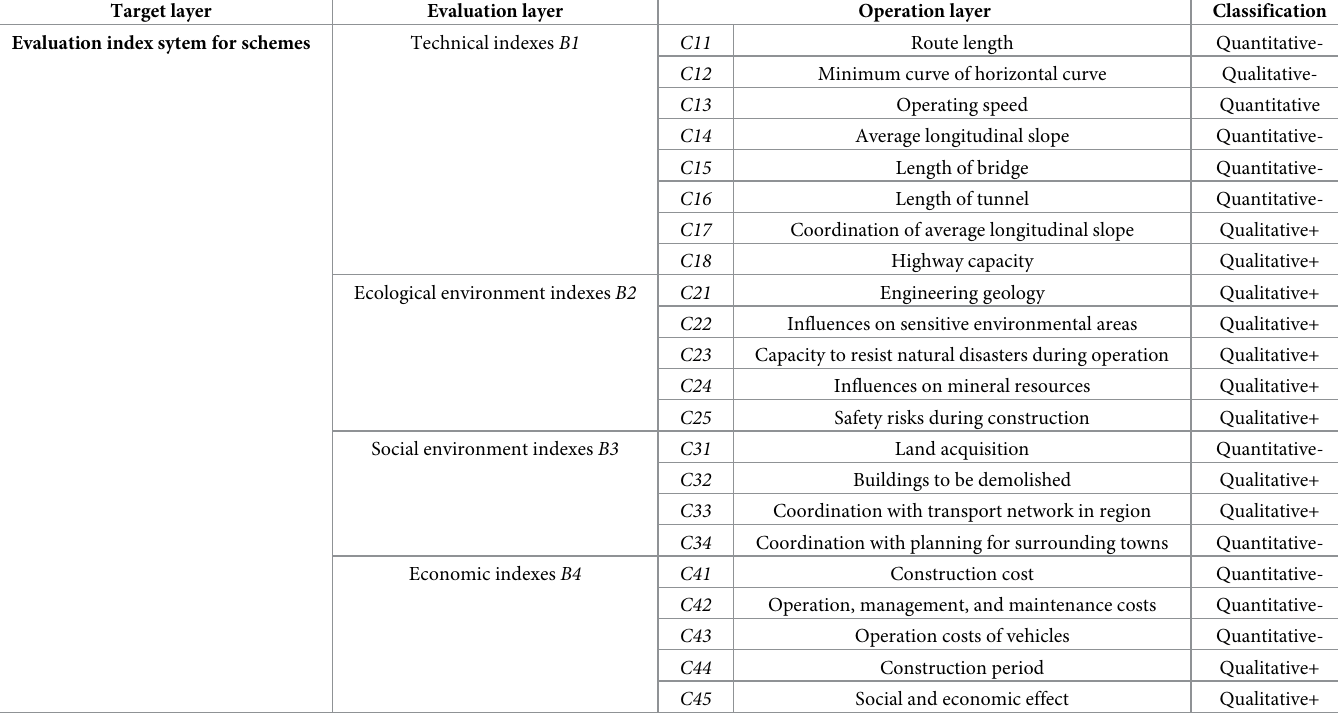
Table 1. Evaluation index system for a highway route